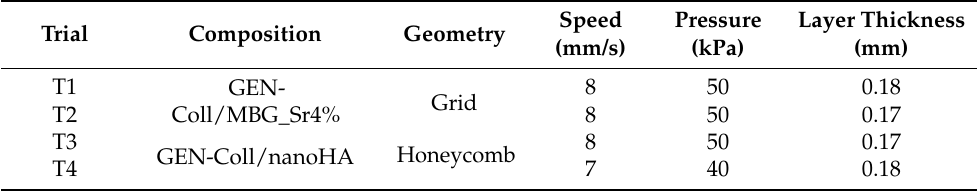
Table 1. Best printing parameters used to process the different in-situ crosslinking suspensions. All trials were performed with a 27 G needle and setting a 15% infill of each layer.